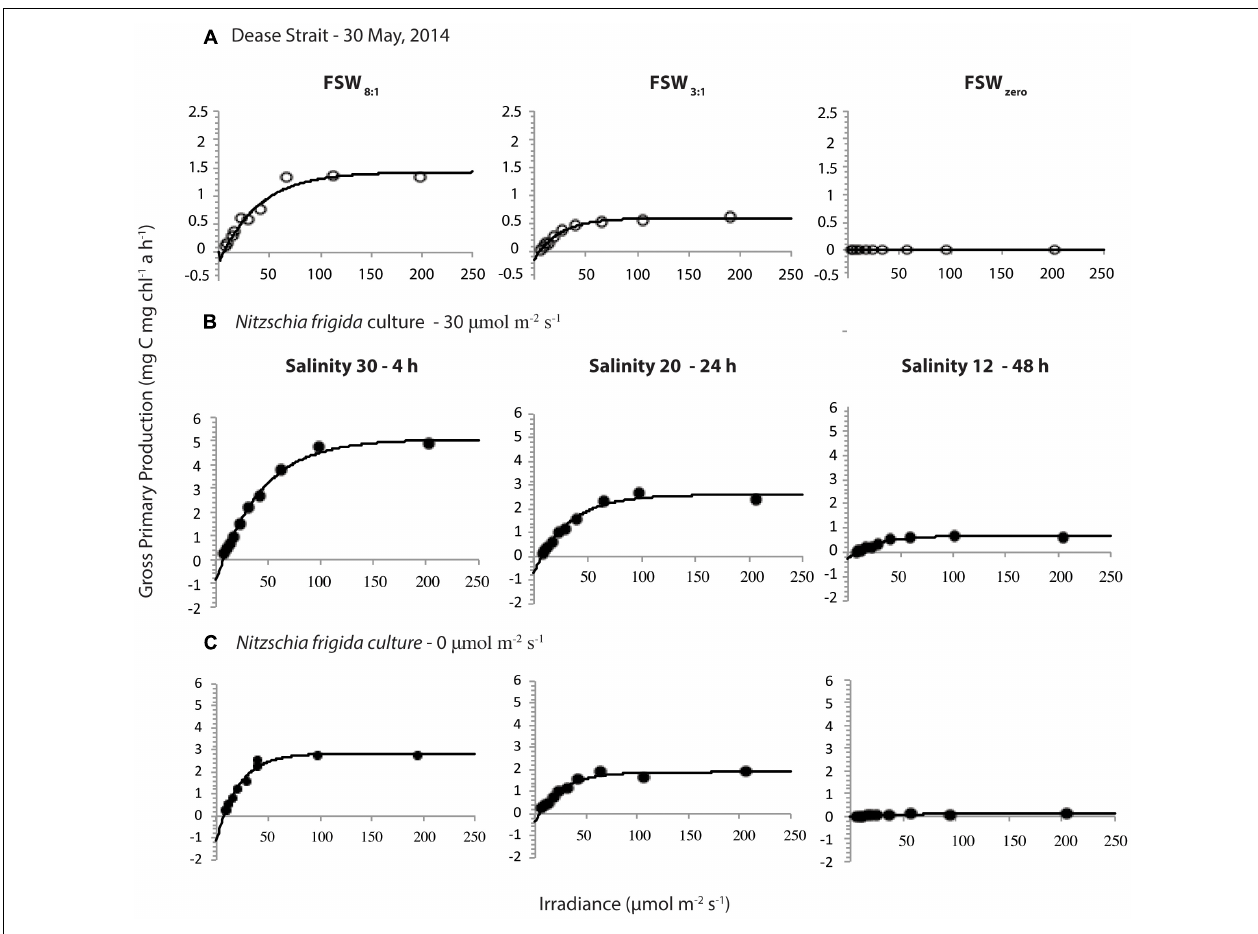
FIGURE 3 | Selected photosynthesis-irradiance curves from samples collected on 30 May in Dease Strait melted in different volume-based ratios of filtered seawater (FSW) to ice (A) , and laboratory cultured samples of Nitzschia frigida grown under 30 µ mol m − 2 s − 1 (B) or in the dark (C) for defined time intervals (hour, h) at salinities of 30, 20, or 12. Laboratory experimental curves shown represent the times of exposure and salinity treatments most comparable to melt procedures of field samples. TABLE 2 | Average values with standard deviation (brackets) of photosynthesis-irradiance parameters (see text for definitions) for samples melted in filtered sea water added at a ratio of eight parts water to one part ice (FSW 8 : 1 ), three parts water to one part ice (FSW 3 : 1 ), and melted without filtered seawater added (FSW zero ). Average ANOVA Fisher’s post hoc test of significance FSW 8 : 1 FSW 3 : 1 vs. FSW